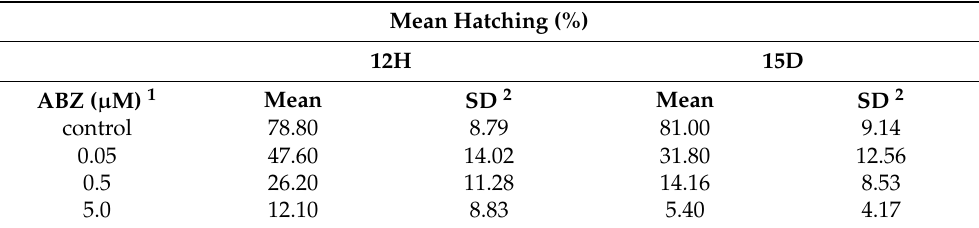
Table 3. Comparison of mean percent hatching at different concentrations between the two versions of the